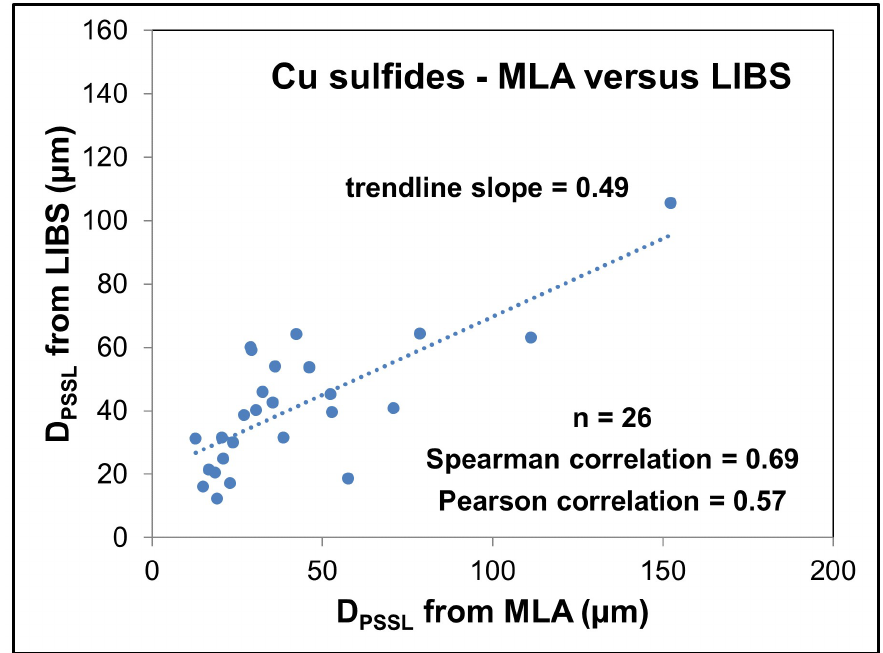
Figure 19. Comparison of the D PSSL (diameter by phase-specific surface area) for combined copper sulfide measured from mineral liberation analysis (MLA) data and the grain size calculated using LIBS data. These calculations assumed that chalcopyrite and bornite equally occur as combined copper